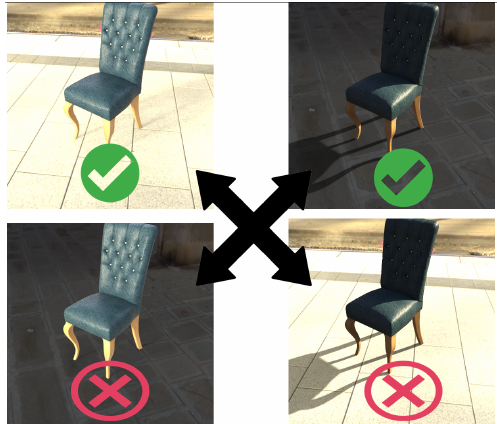
Figure 16. We created a training dataset to train lighting transfer through CycleGAN by generating pairs of augmented 3D models in an HDR environment. The top two images are correct because the models are illuminated by the environment they are placed in (augmented correctly). The two bottom images are obtained by replacing the environment of the background. We insert the model into one environment, but illuminate it with another